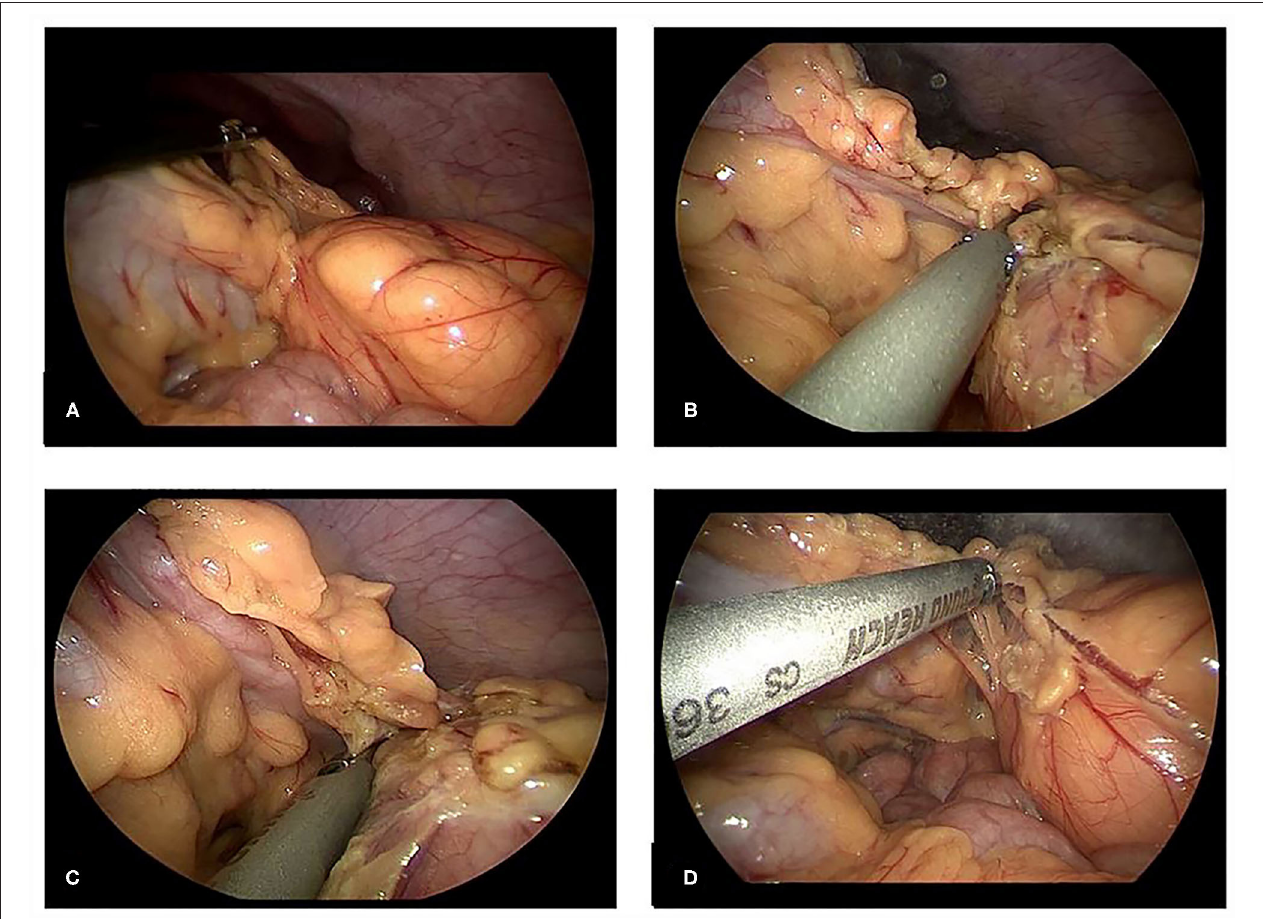
FIGURE 2 | (A) , Laparoscopic examination of the left mid-upper abdominal tumor, which was yellow, solid, isolated, derived from the greater omentum, without torsion. (B,C) , Ultrasonic knife separates the omentum and the tumor. (D) , Ultrasonic scalpel coagulates the tumor blood supply